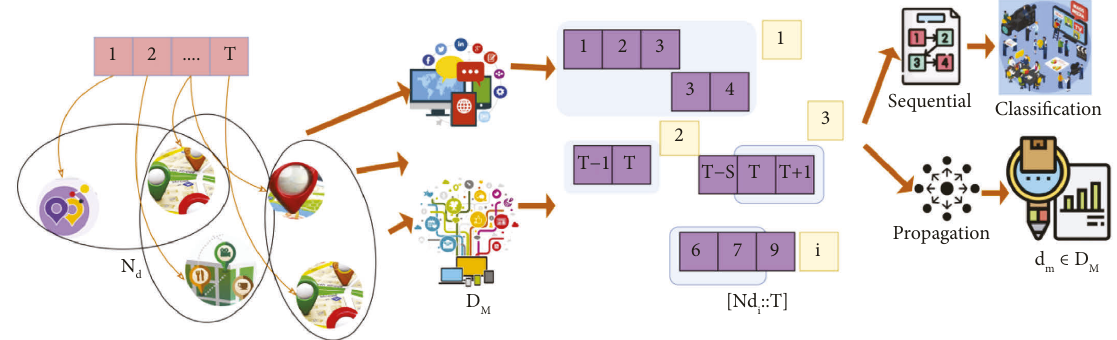
Figure 2: Sequential instance for observed